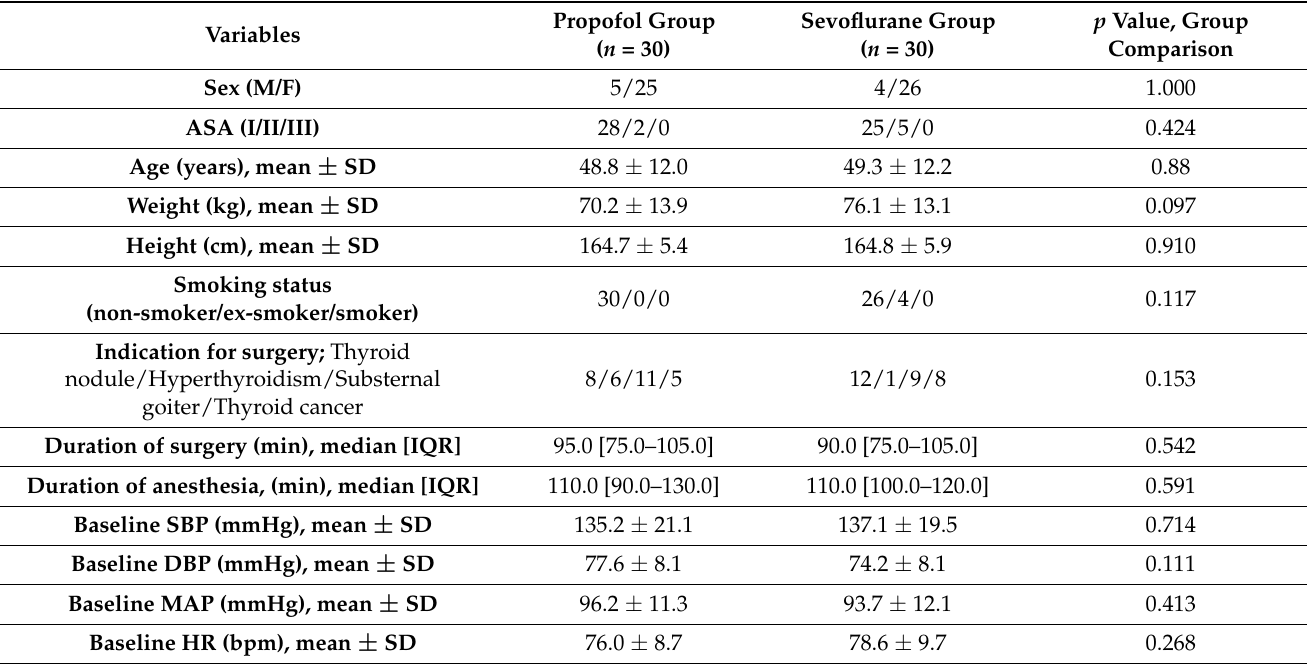
Table 1. Demographic and baseline hemodynamic characteristics of the two